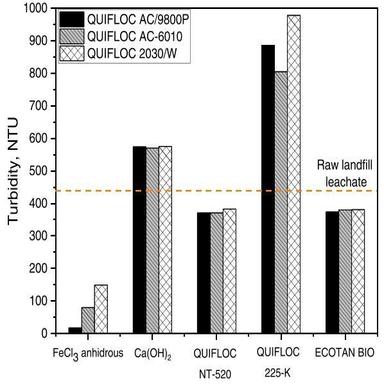
Landfill leachate turbidity after C/F stage with combination of 1 g/L of coagulant with 1 g/L of flocculants at pH 5.